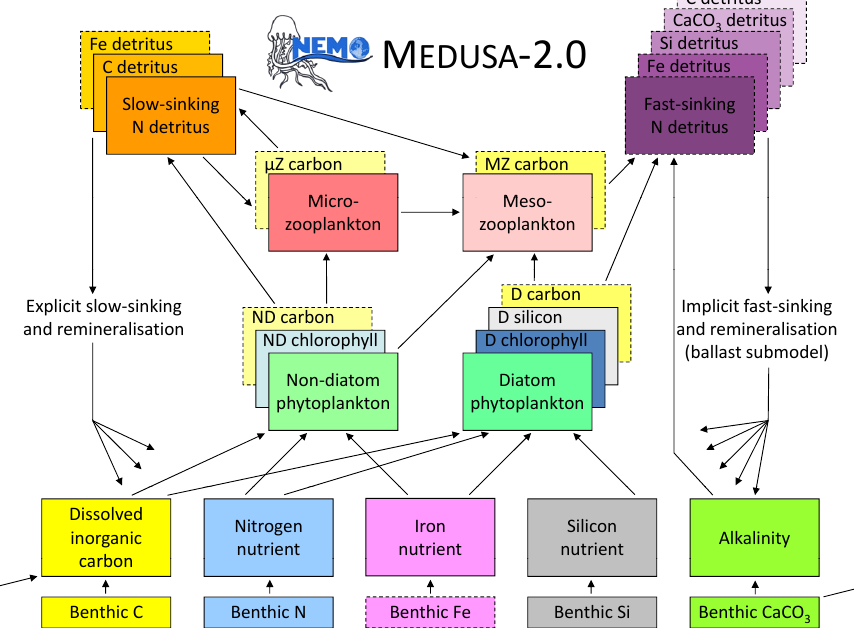
Fig. 1. Schematic diagram of the components and interactions in the M EDUSA -2.0 model. Boxes with solid borders indicate explicitly modelled state variables, while boxes with dashed borders indicate implicitly modelled components. Overlapping boxes indicate components for which multiple currencies are modelled (e.g. different elements, chlorophyll). The smaller boxes at the bottom of the diagram refer to benthic reservoirs of model currencies that are fed by sinking detrital material (slow- and fast-sinking). For reasons of diagrammatic clarity, dissolved oxygen and its connections to other state variables are omitted here. Note that the dissolution of benthic CaCO 3 releases both DIC and